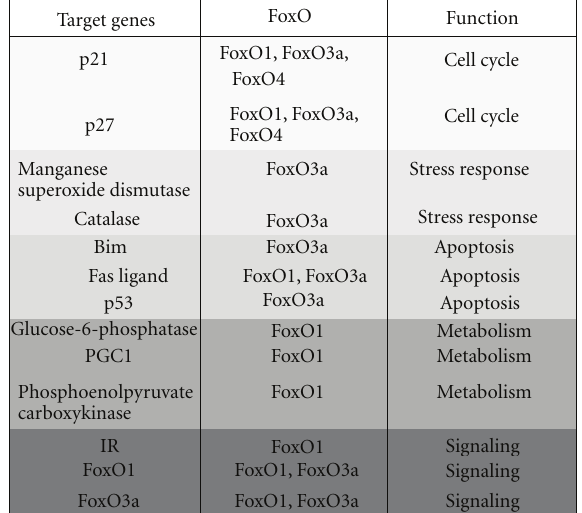
Figure 2: Function and targets genes of FoxO transcription factors. Abbreviations: IR, insulin receptor; PGC1, peroxisome- proliferative-activated receptor- γ (PPAR γ ) coactivator 1; BIM, Bcl2-interacting mediator of cell death; p21, cyclin-dependent kinase inhibitor 1 (review in [58]).